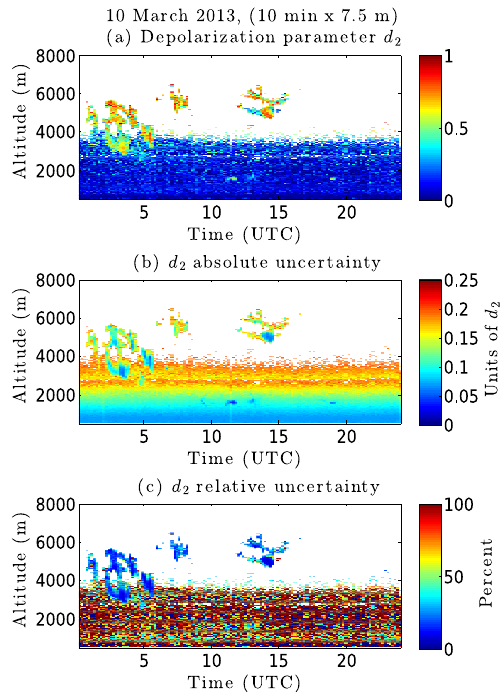
Figure 11. The d 2 depolarization values from 10 March 2013, with 10min × 7.5m resolution, excluding anywhere with more than 0.2 absolute uncertainty in depolarization parameter units. (a) d 2 val- ues; (b) uncertainties associated with the d 2 values in units of de- polarization parameter; (c) relative uncertainties in units of percent. The calibration profile is based on 20min × 7.5m resolution calcu-